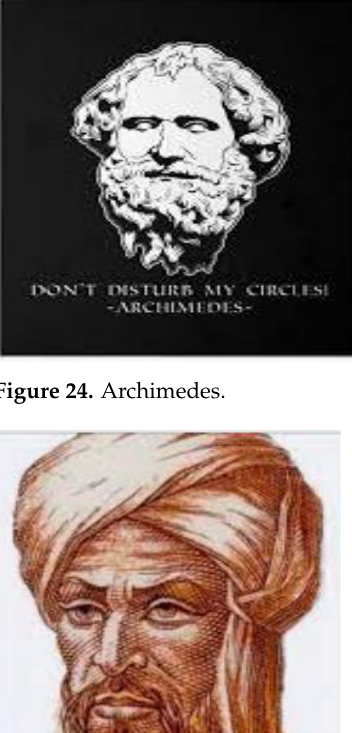
Figure 25. Khwarizmi.